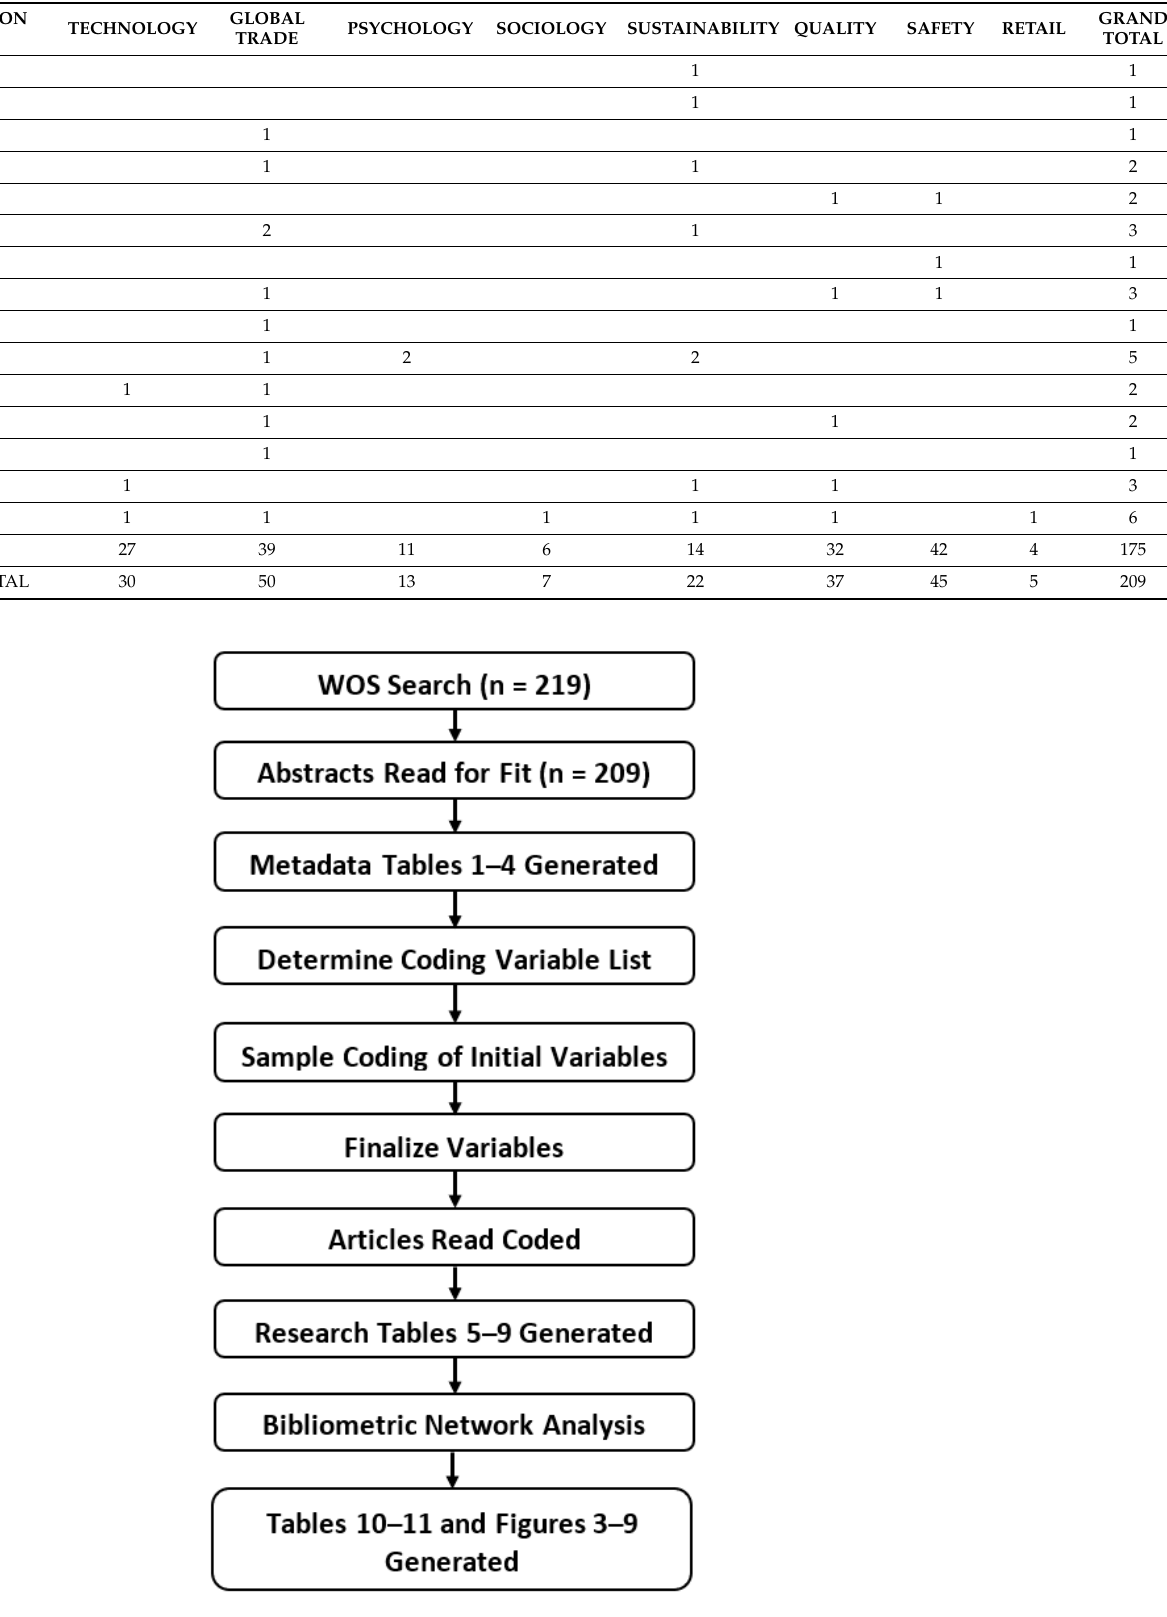
Figure 1. Flow Chart of the Research Process.